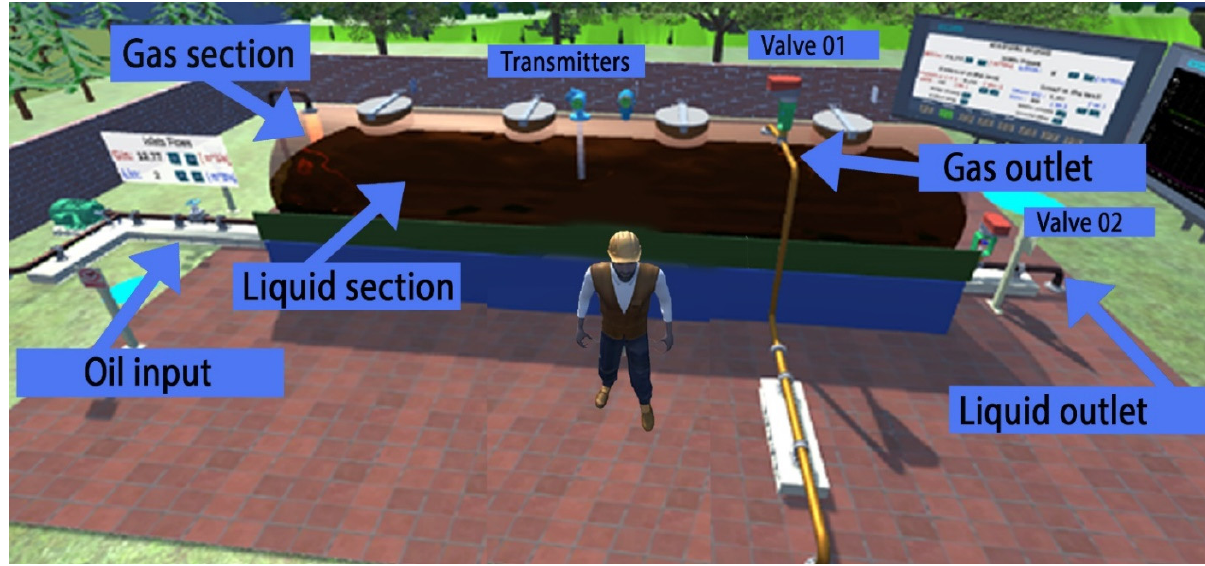
Figure 8. Virtualized biphasic separator.